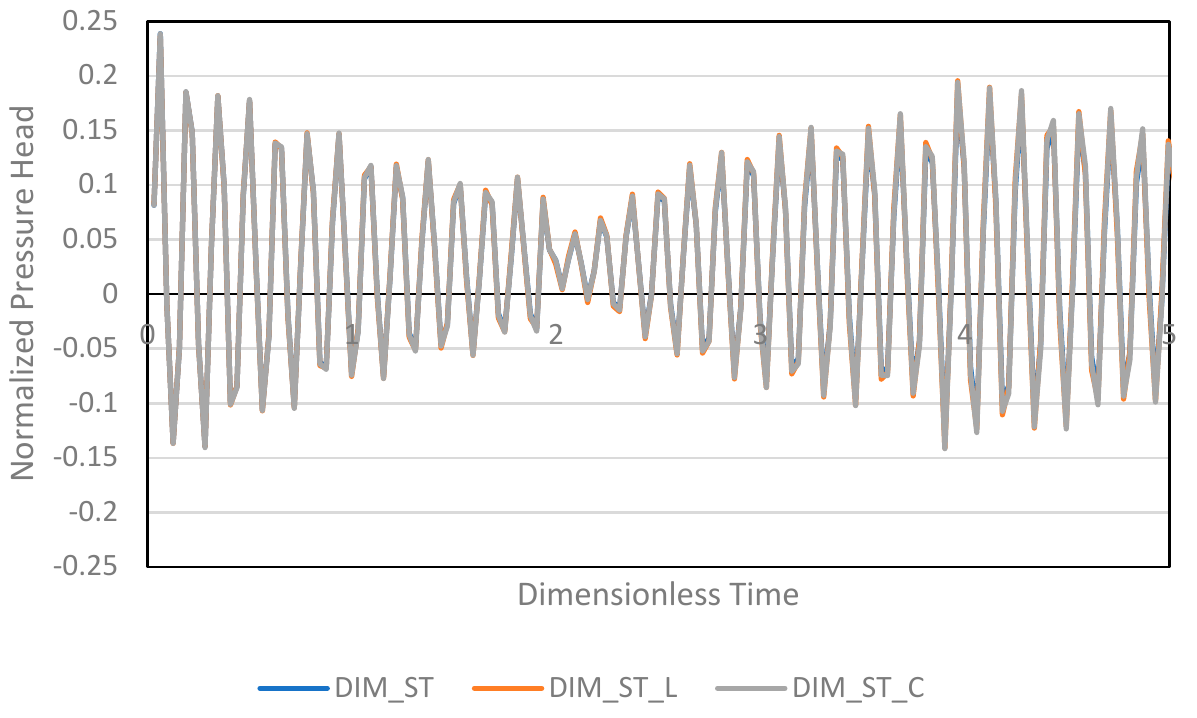
Figure 3. Predictions of normalized pressure head by DIM_ST and the IRM with surge tank (IRM_ST) adapted with permission from Ref. [11] at downstream valve.